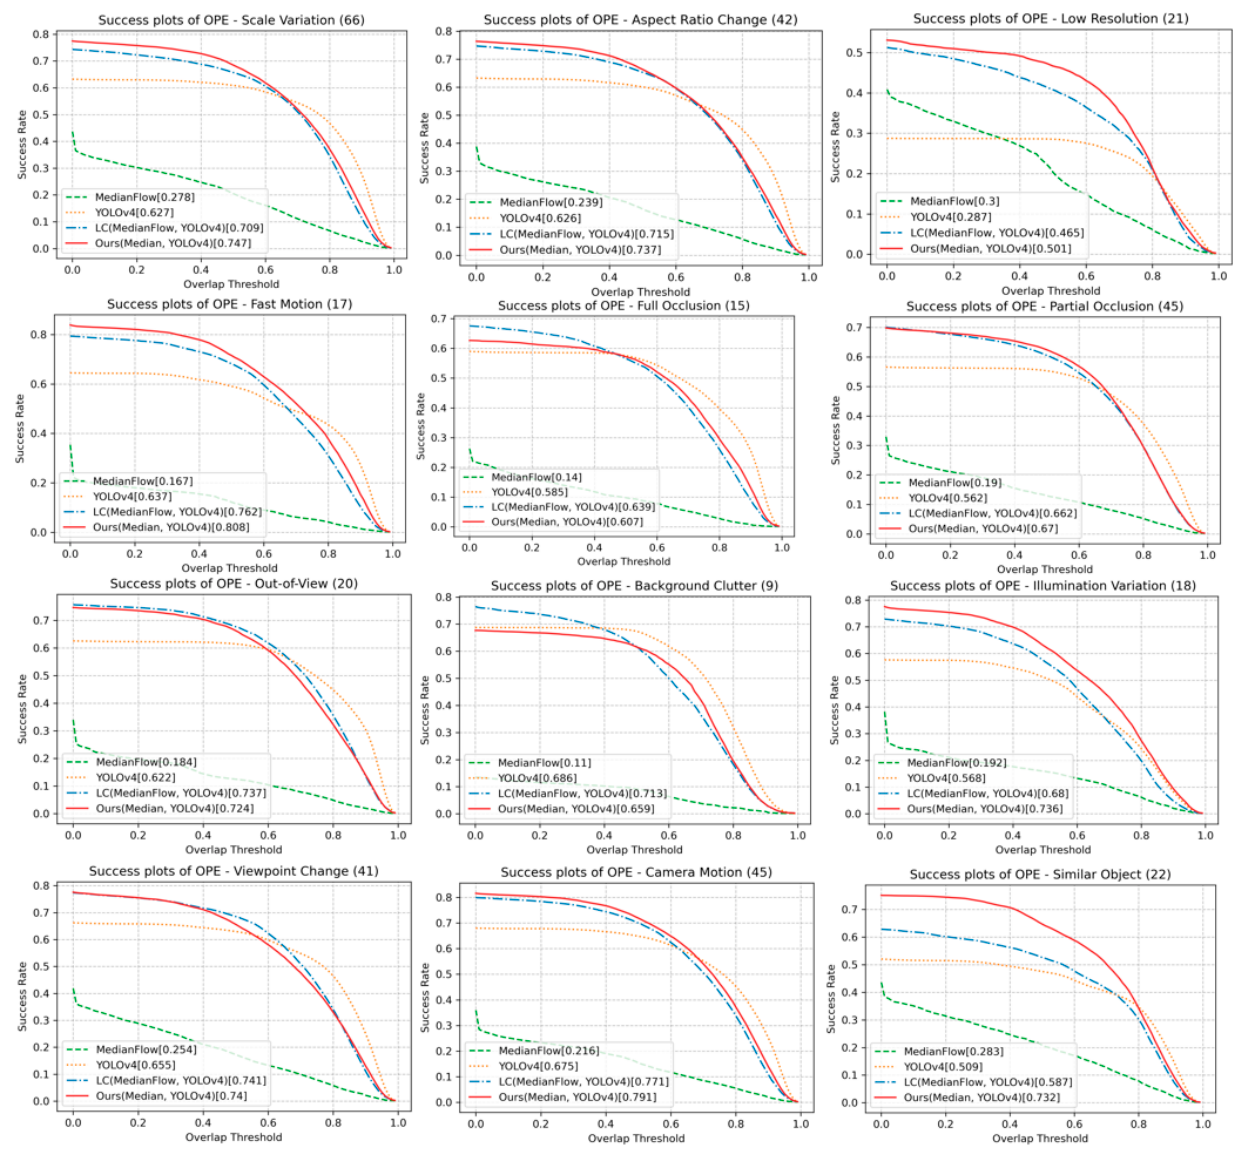
Figure 8. Success plots on different scenarios in UAV123 dataset.